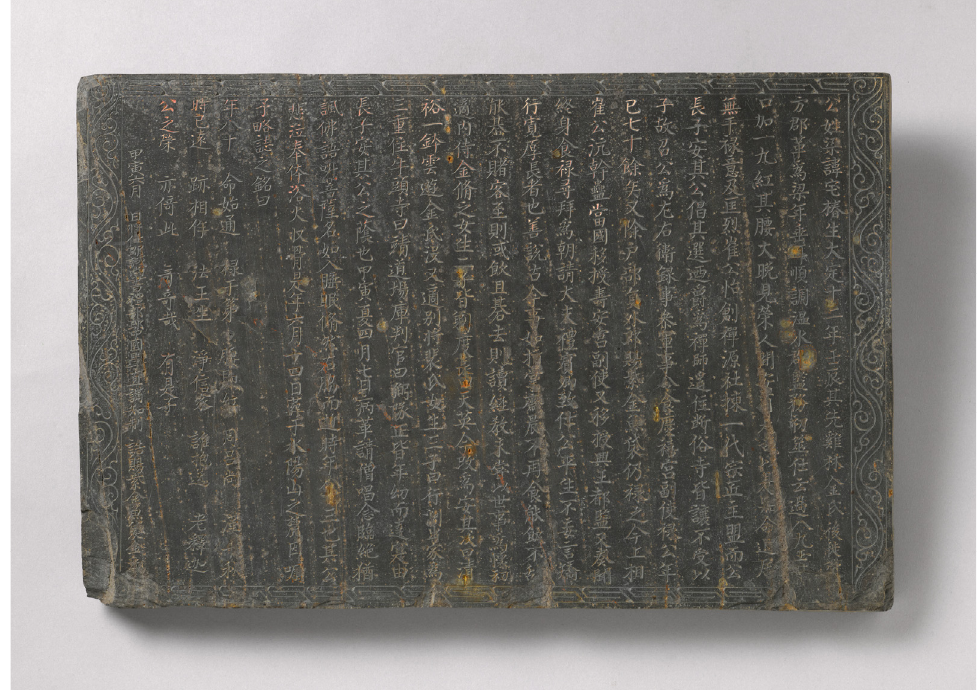
Figure 8. Biographical account on the front of Yang T’aekch’un’s tomb epitaph. Koryŏ dynasty, dated 1254. 57.5 × 37.5 × 4.5 cm. National Museum of Korea.